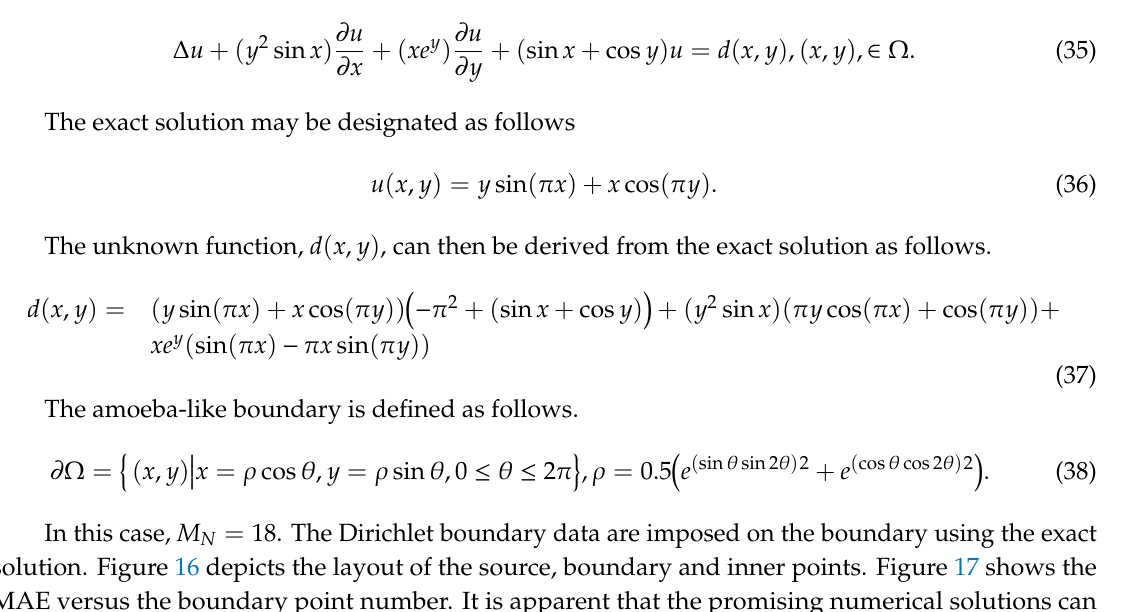
Figure 15. Results comparison between this study and the analytical solution.